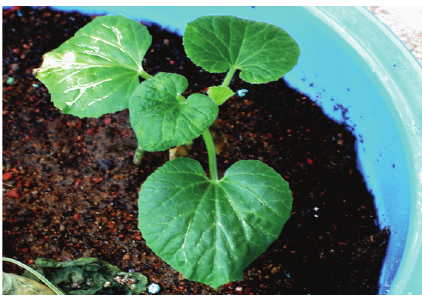
Figure 3: Symptom appearance at 14 day-postinoculation (dpi) on muskmelon plants caused by pCG+FSRTRE-derived transcripts.